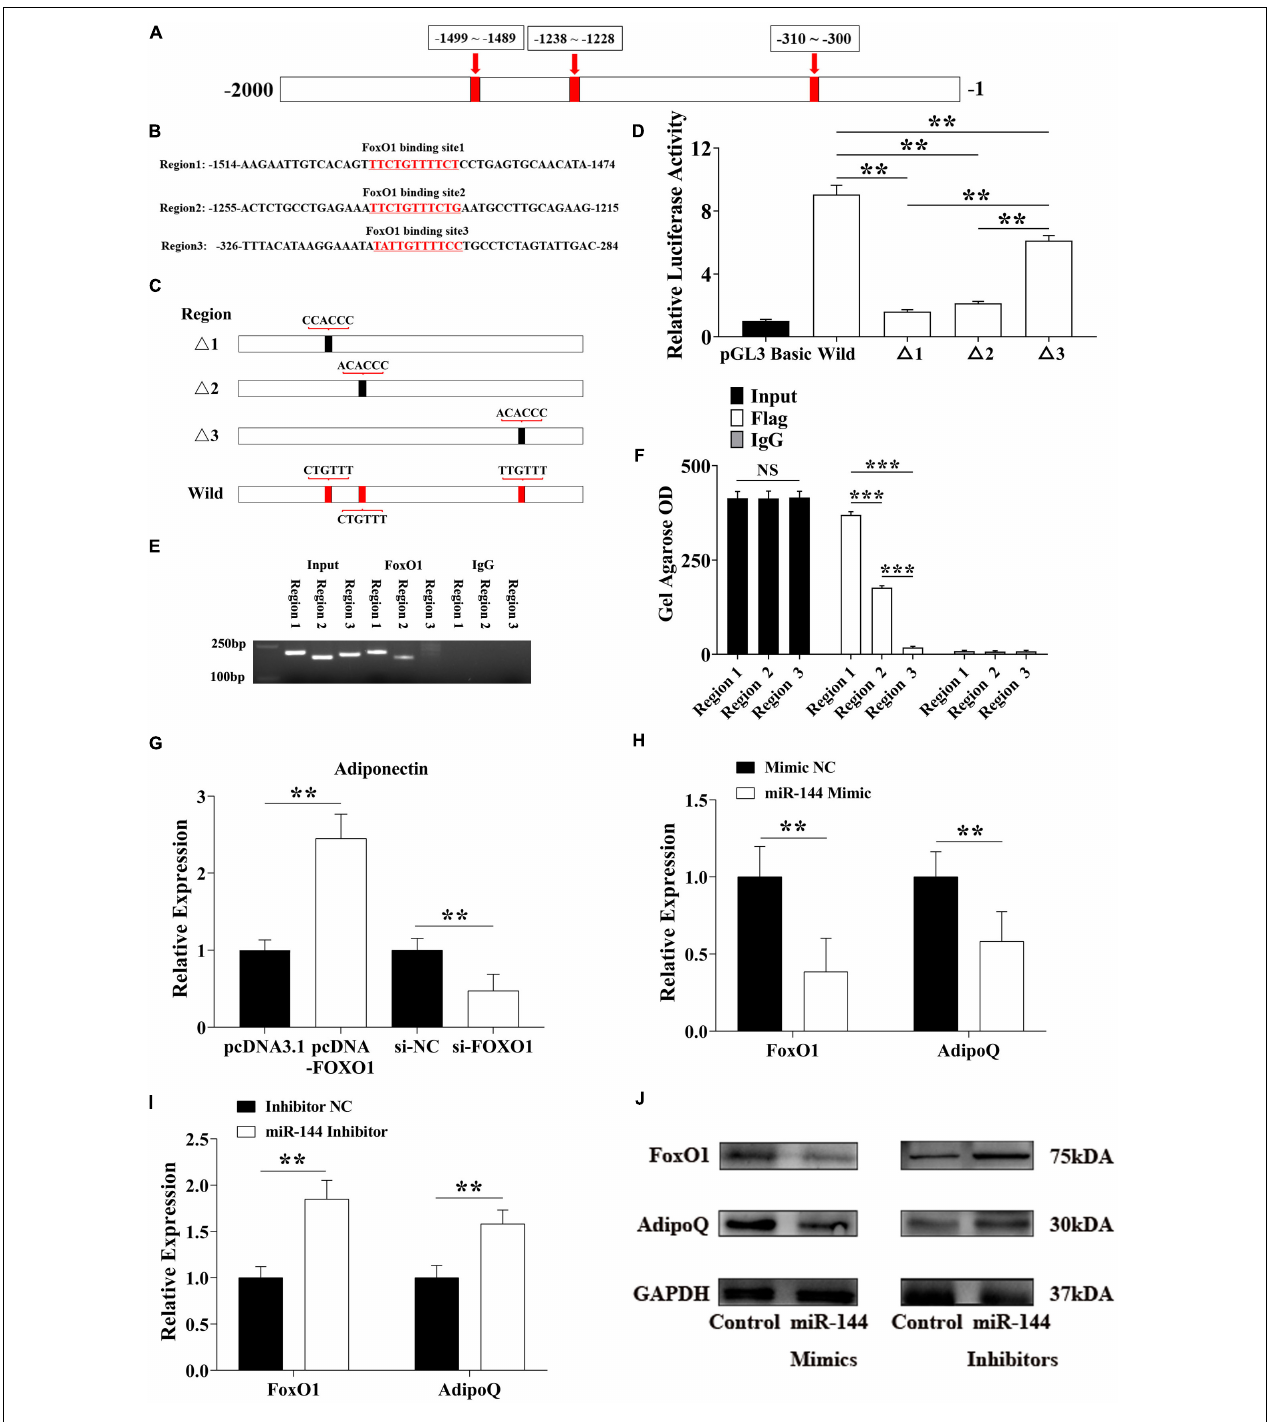
FIGURE 5 | miR-144 inhibits FoxO1 to reduce its regulation of adiponectin and promote adipogenesis. (A,B) The specific binding location of the FoxO1 binding site in the -2,000 bp region (A) and the response element at each site (B) . (C) Constructed homologous recombinant pGL3 basic plasmid, including three mutational FoxO1 binding sites and a whole region contained three wild binding sites. (D) pGL3-regions directed luciferase gene reporter plasmid (pGL3-regions) was co-transfected with FoxO1 encoding pcDNA3.1 + plasmids in porcine pre-adipocytes. Luciferase activity was measured 48 h after transfection. (E,F) ChIP-PCR detected the FoxO1 binding sites in the AdipoQ promoter region (E) , and the OD value was visualized by the ImageJ software (F) . (G) Detected adiponectin expressed level after FoxO1 overexpression and interference. (H,I) Detected FoxO1 and adiponectin expressed level after miR-144 mimics (H) and inhibitors (I) overexpressed in pre-adipocytes. (J) Western blotting analysis of FoxO1 and adiponectin proteins expression level after miR-144 mimics and inhibitors overexpressed in pre-adipocytes. ** p < 0.01 and *** p < 0.001, respectively.